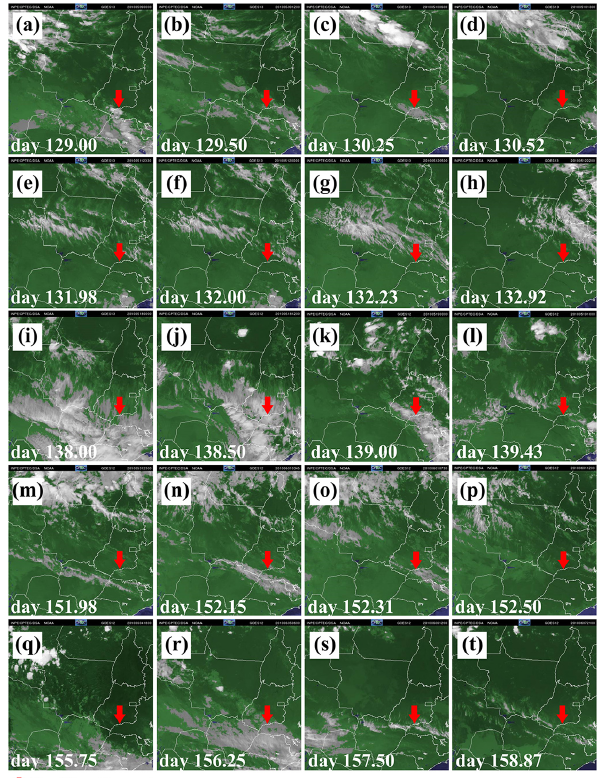
Figure 2. Cloudiness associated with cold front passages over the Itumbiara Reservoir observed by GOES. False color composites (R2G3B1) during the F1 (a–d) , F2 (e–h) , F3 (i–l) , F4 (m–p) and F5 (q–t)